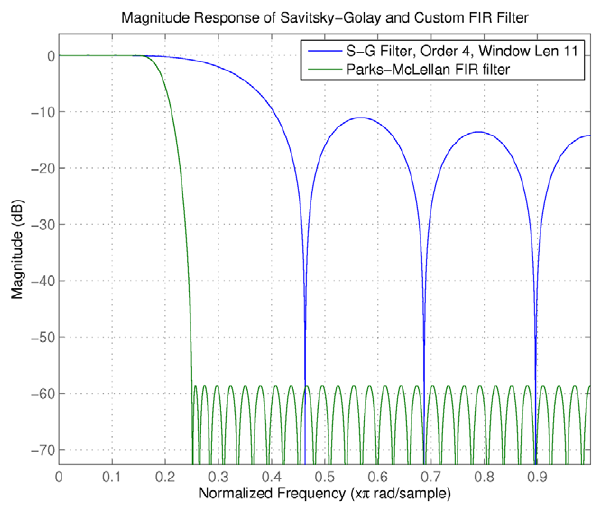
Figure 2. 67 th order FIR filter frequency response designed for flat-pass band analogous to a Savitsky-Golay filter, but with better high-frequency noise suppression properties.